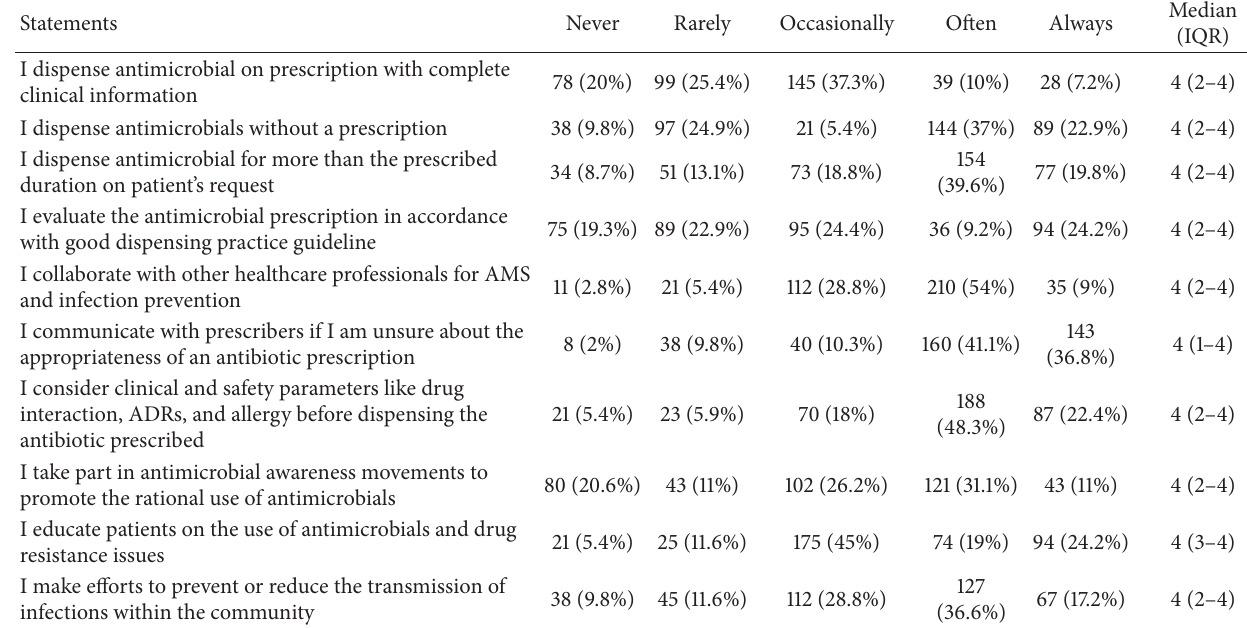
Table 3: Community pharmacists’ practice towards AMS ( 𝑁 = 389